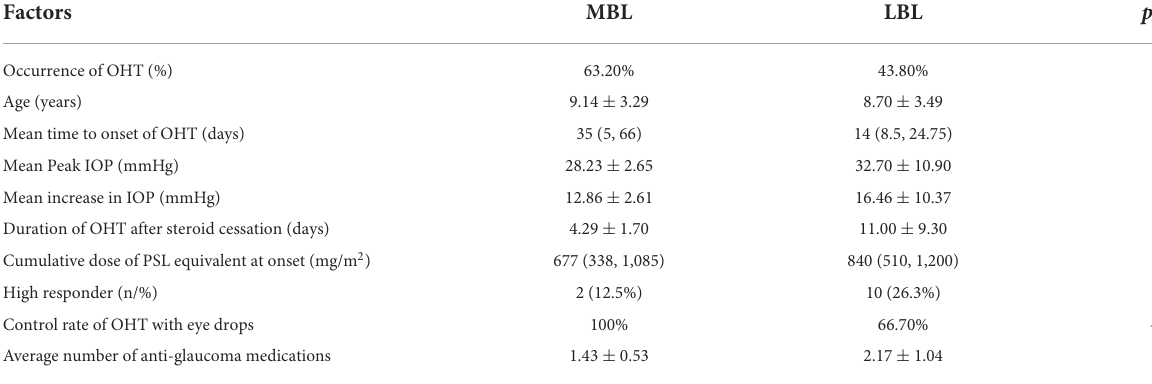
TABLE 2 Comparsions of OHT-associated variables on patients with OHT between the MBL and LBL group.